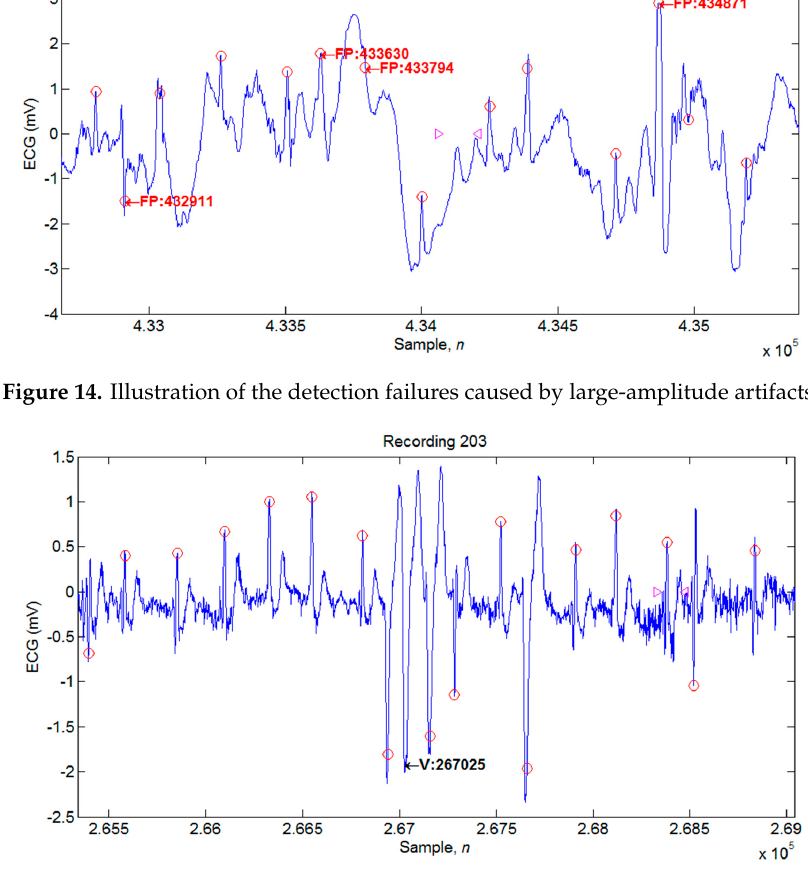
Figure 15. Illustration of the detection failure caused by the distance shorter than 100 samples between two successive QRS peaks.